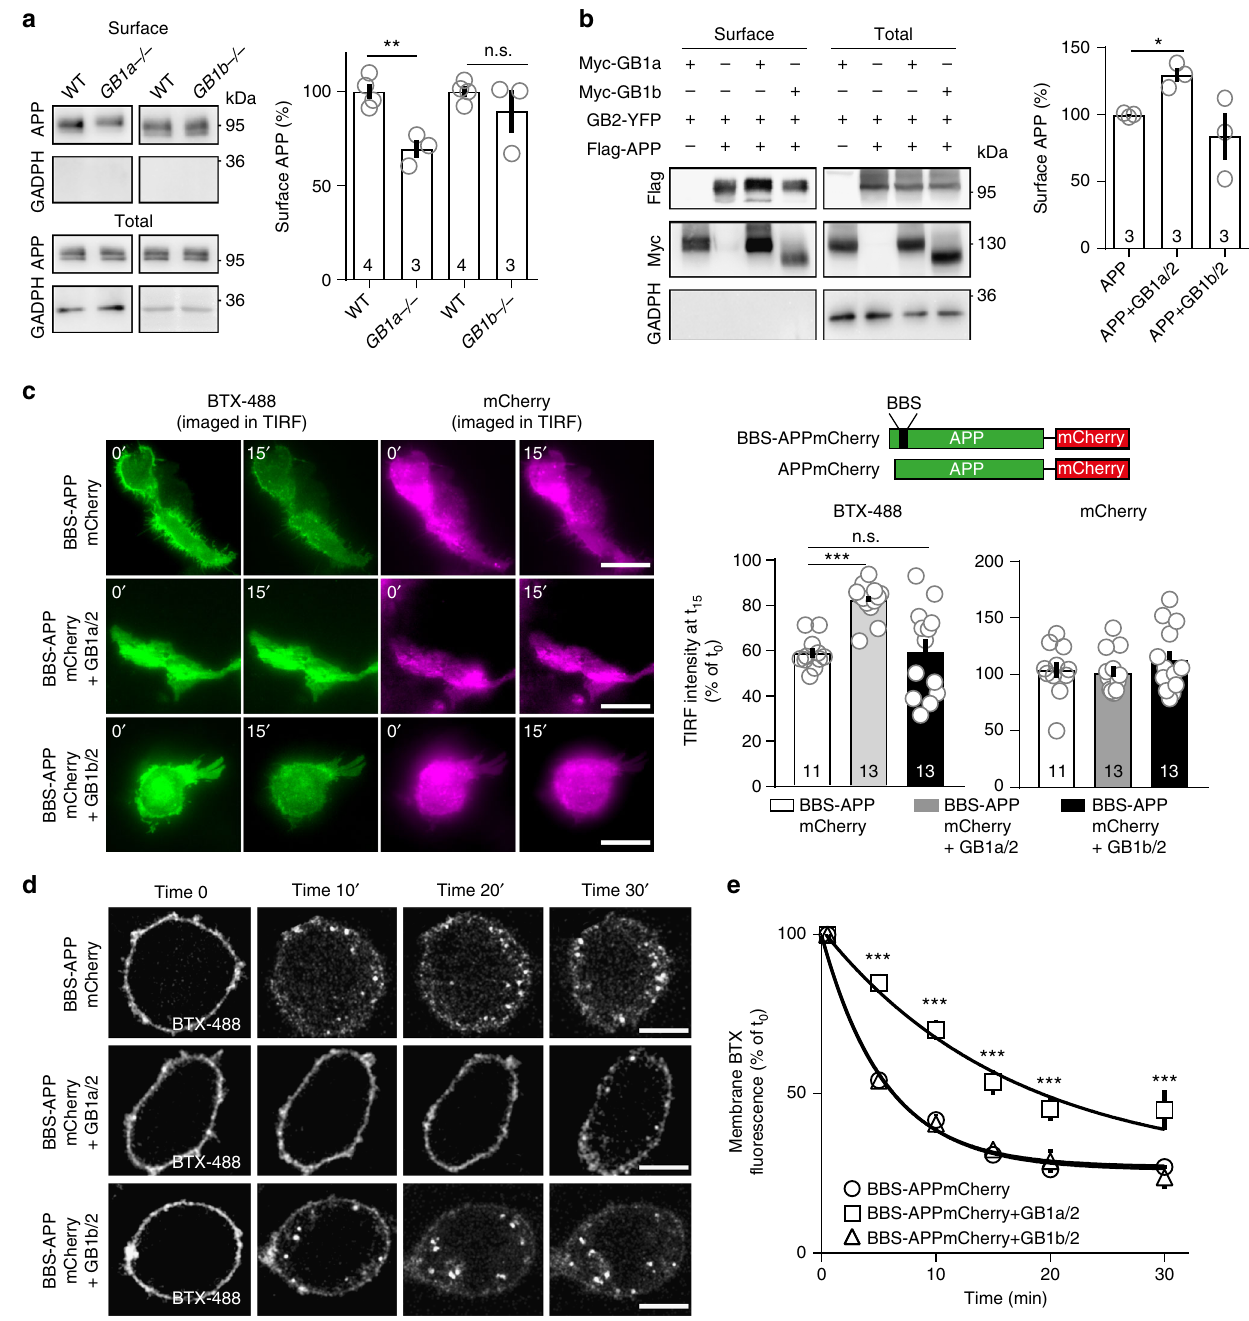
Fig. 7 GB1a stabilizes APP at the cell surface. a Cell surface biotinylation of APP in cultured hippocampal neurons of GB1a − / − , GB1b − / − , and control WT littermate mice. Bar graph summarizes the densitometric quanti fi cation of APP surface levels: WT 100.0 ± 4.1%, GB1a − / − 69.6 ± 4.9%, ** P < 0.01, unpaired Student ’ s t -test; WT 100.0 ± 2.9%, GB1b − / − , 89.6 ± 11.2%, P > 0.05, Mann-Whitney. b Cell surface biotinylation of APP in HEK293 cells in the presence or absence of GB1a or GB1b. Bar graphs summarizes the densitometric quanti fi cation of APP surface levels. APP: 100 ± 0.9%; APP + GB1a/2: 129.7± 5.3%; APP + GB1b/2: 83.9 ± 17.5%; * P < 0.05, one-way ANOVA; n = 3 independent experiments. c To study APP internalization the α -BTX binding site (BBS) was fused to the extracellular N-terminus of APPmCherry (BBS-APPmCherry). BTX-488 and mCherry cell surface fl uorescence of HEK293 expressing